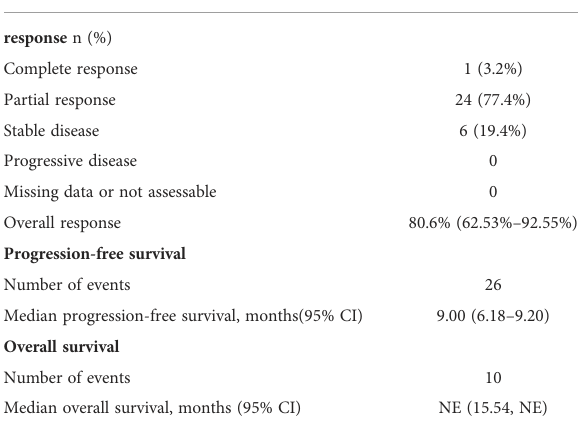
TABLE 4 Response and survival data (FAS population).